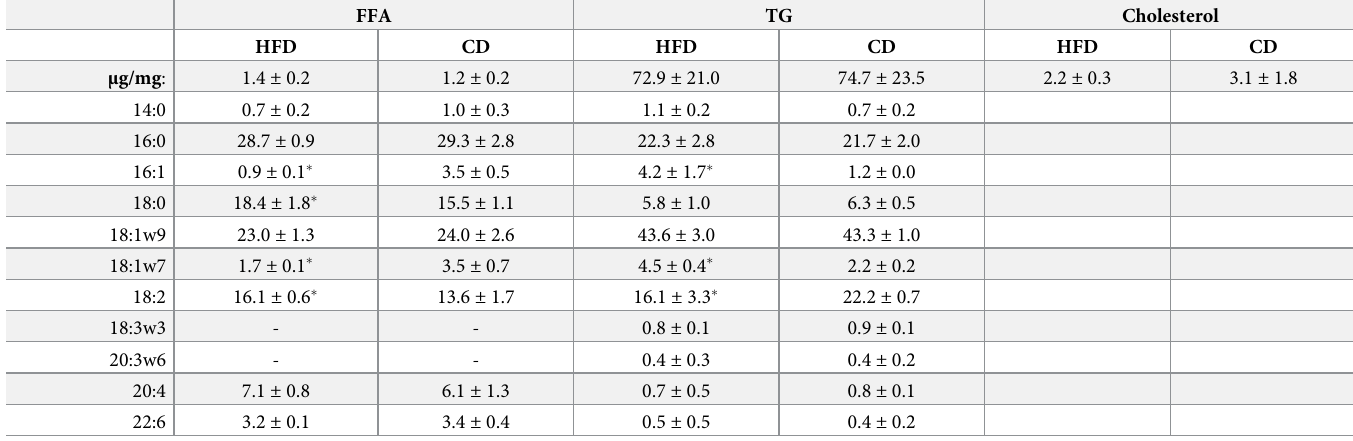
Table 2. Liver lipids in cDNA-uPA/SCID mice. FFA